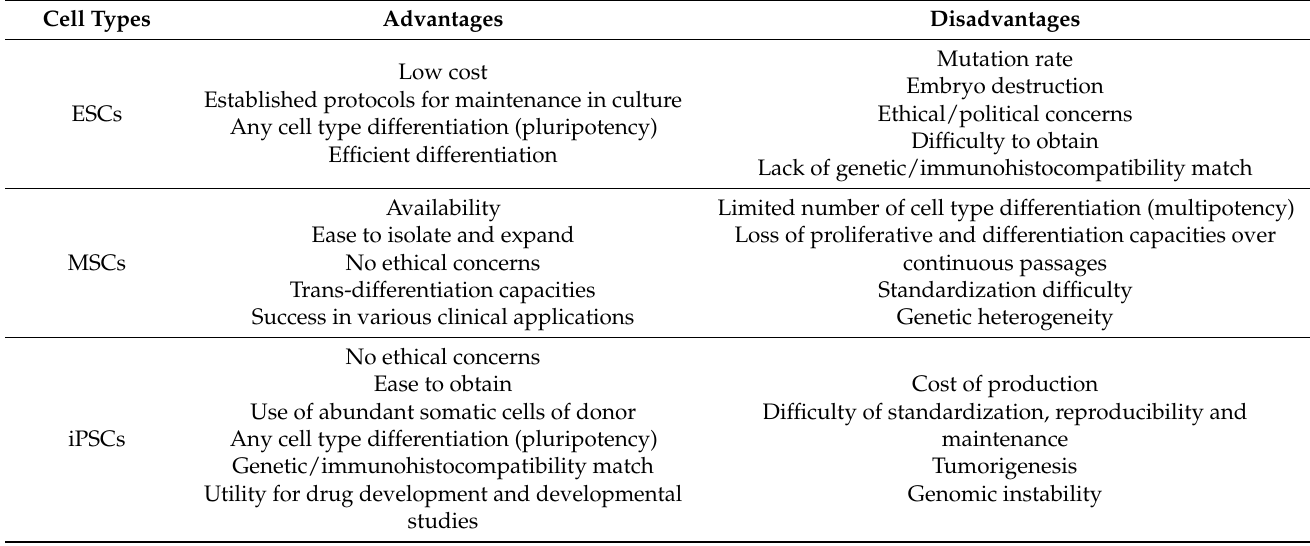
Table 1. Main advantages and disadvantages of different types of stem cells: ESCs, MSCs, and iPSCs. Cell